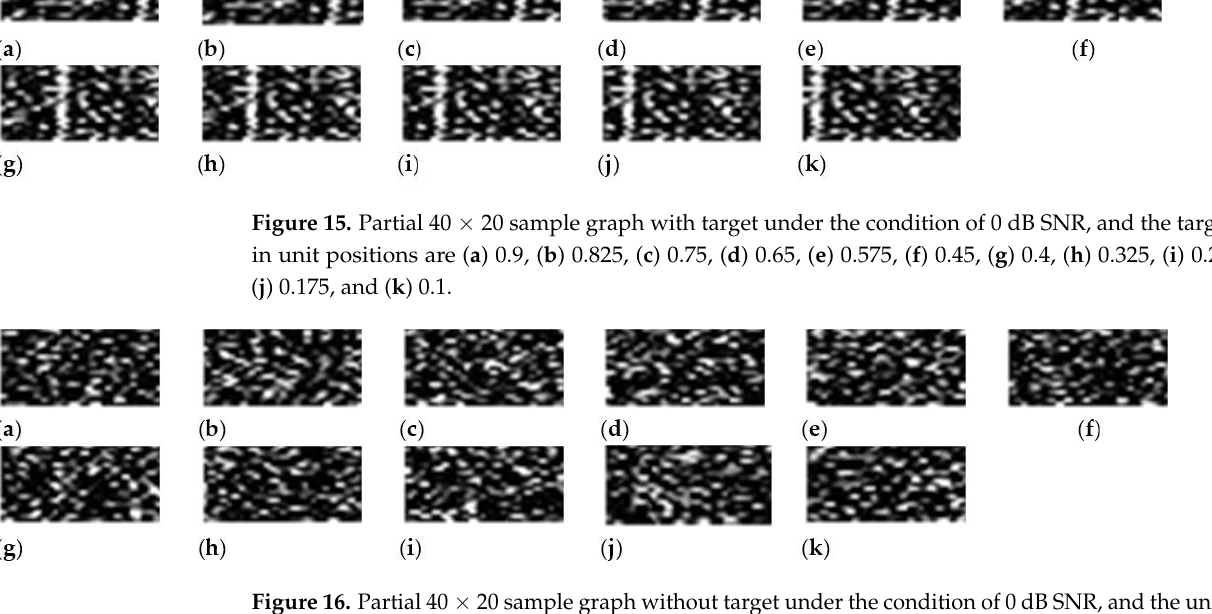
Figure 16. Partial 40 × 20 sample graph without target under the condition of 0 dB SNR, and the units are ( a ) 400th, ( b ) 800th, ( c ) 1200th, ( d ) 1600th, ( e ) 2000th, ( f ) 2400th, ( g ) 2800th, ( h ) 3200th, ( i ) 3600th, ( j ) 4000th, and ( k ) 4400th.